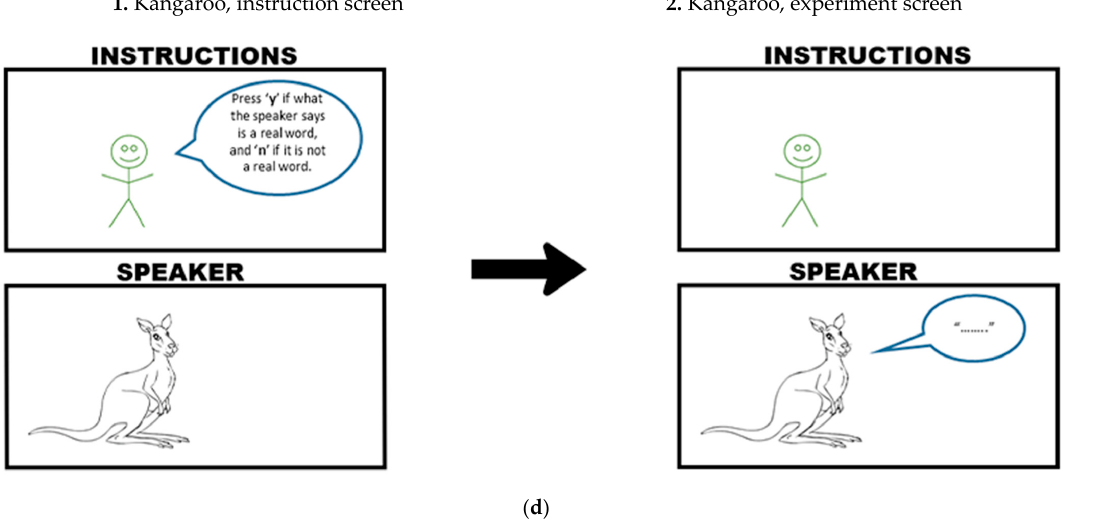
Figure 4. ( a ) Example block from baseline-incidental condition. ( b ) Example block from priming- incidental condition. ( c ) Example block from baseline-speaking condition. ( d ) Example block from priming-speaking condition.